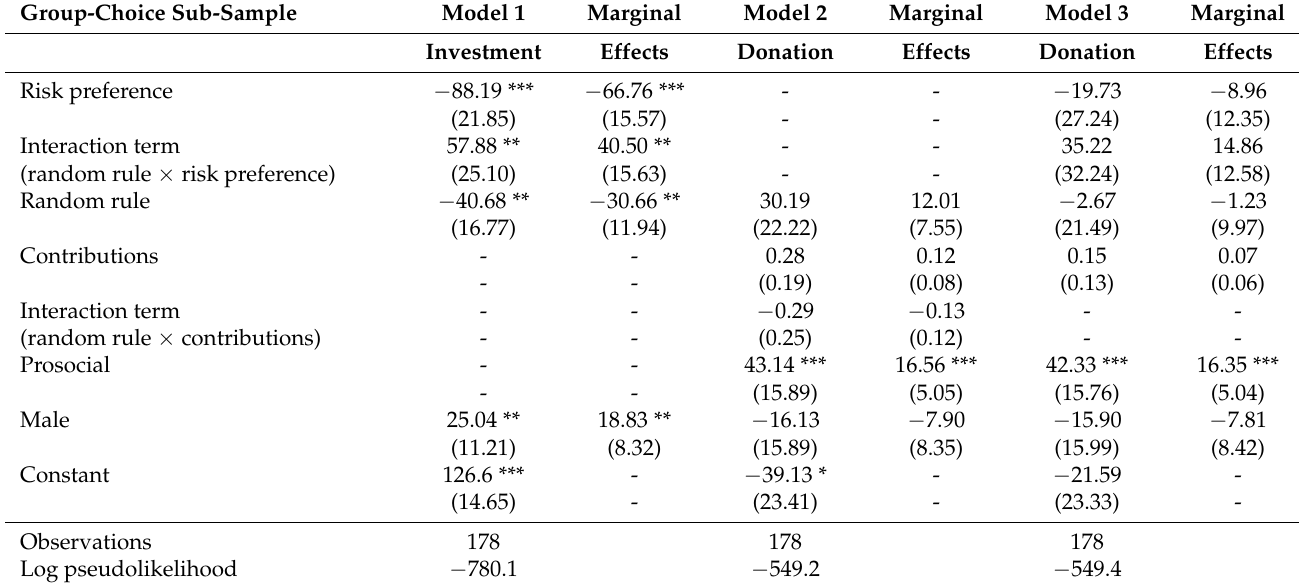
Table 7. Estimation results for the group-choice sub-sample (Tobit